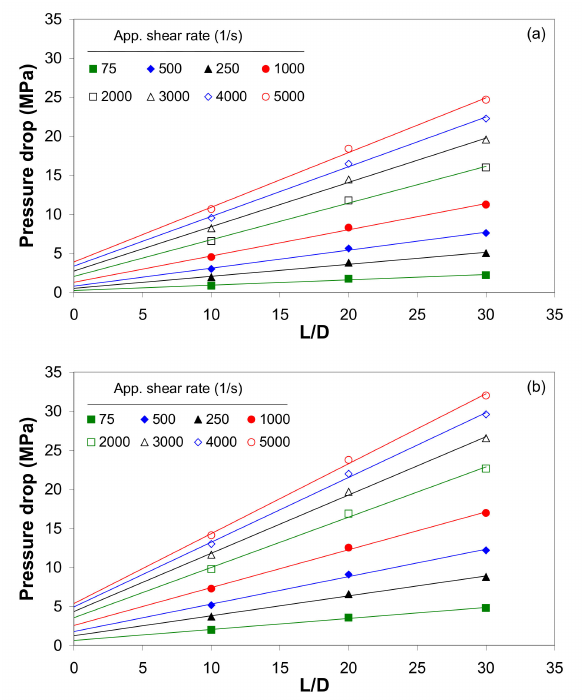
Figure 3. Bagley plot for the LDPE / MWCNT composite with ( a ) 0.1 wt.% and ( b ) 5 wt.% of MWCNTs at 120 ◦